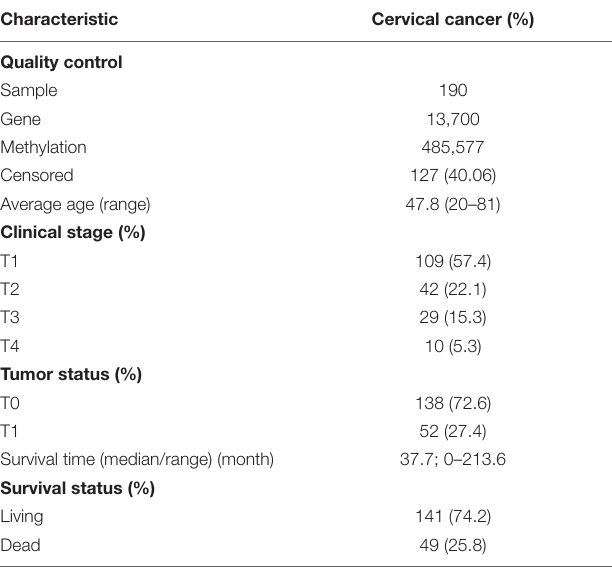
TABLE 1 | Summary information of clinical characteristics for cervical cancer available from TCGA.